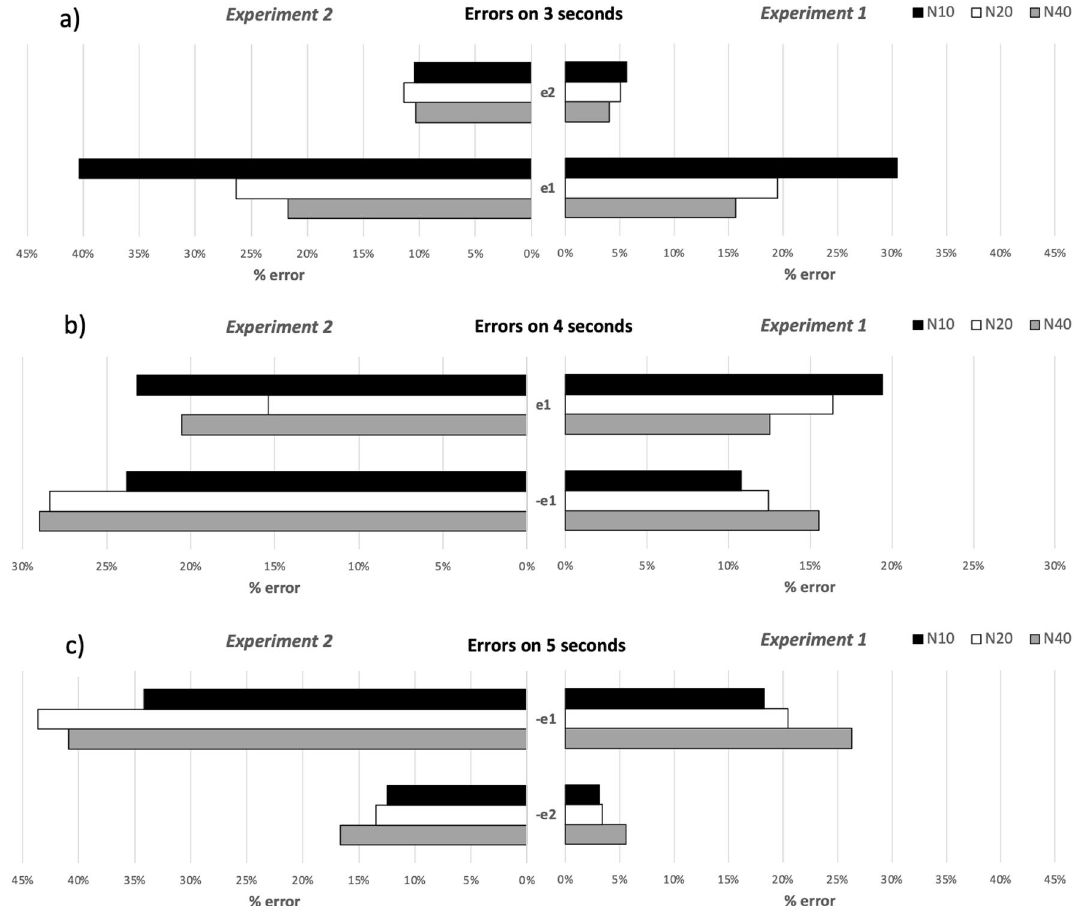
Figure 3. Clustered bars showing error rates at 3-s (upper panels), 4 s (middle panel) and 5 s (upper panel) per steps ( N10 , N20 , and N40 ) and error type (− e1/2: underestimation of 1 or 2 s, e1/2: overestimation of 1 or 2 s) for Experiments 1 and